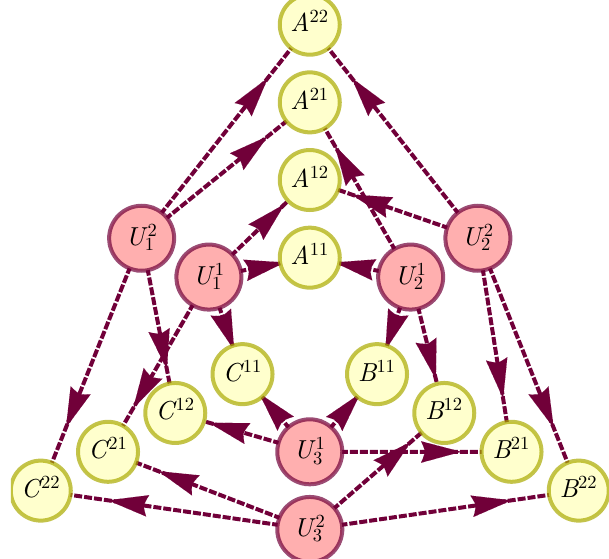
Figure 5: The second-order inflation graph of the triangle